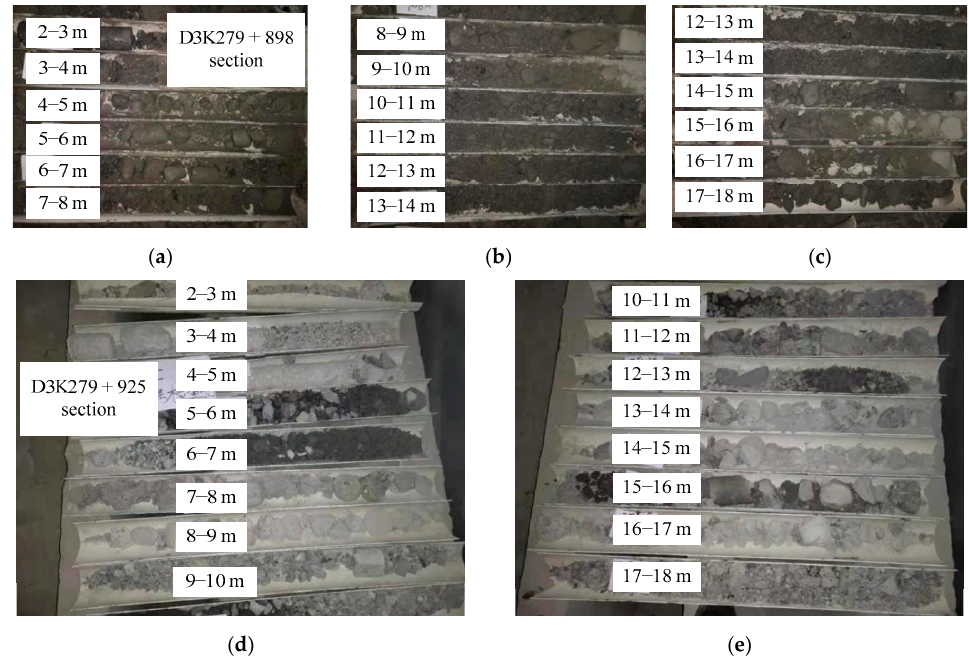
Figure 14. The cores of D3K279 + 898 and D3K279 + 925 section. ( a ) D3K279 + 898 section 2–8 m. ( b ) D3K279 + 898 section 8–14 m. ( c ) D3K279 + 898 section 12–18 m. ( d ) D3K279 + 925 section 2–10 m. ( e ) D3K279 + 925 section 10–18